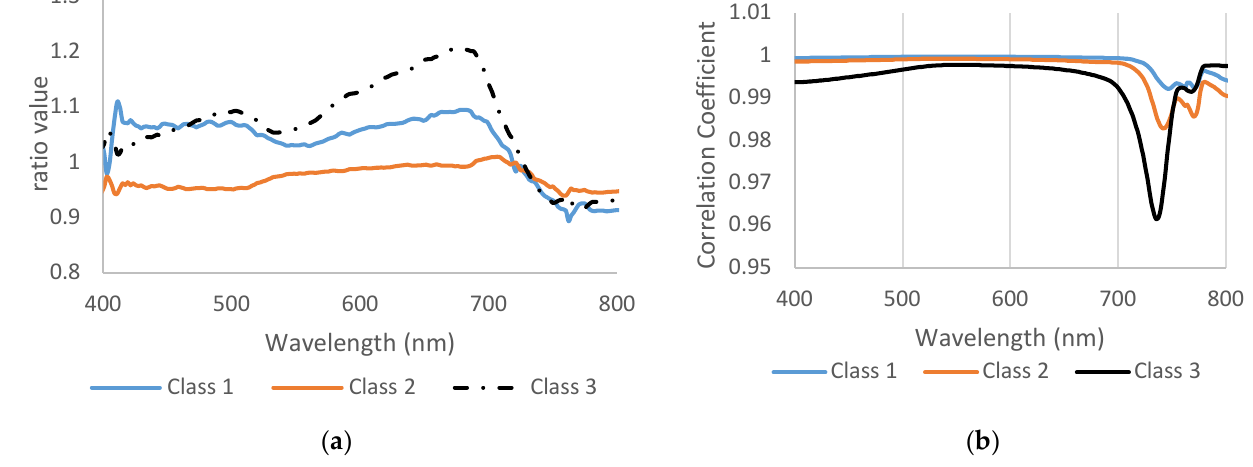
Figure 4. ( a ) The wavelength ratio or disease sensitivity and ( b ) the correlation coefficient between healthy and infected plants.